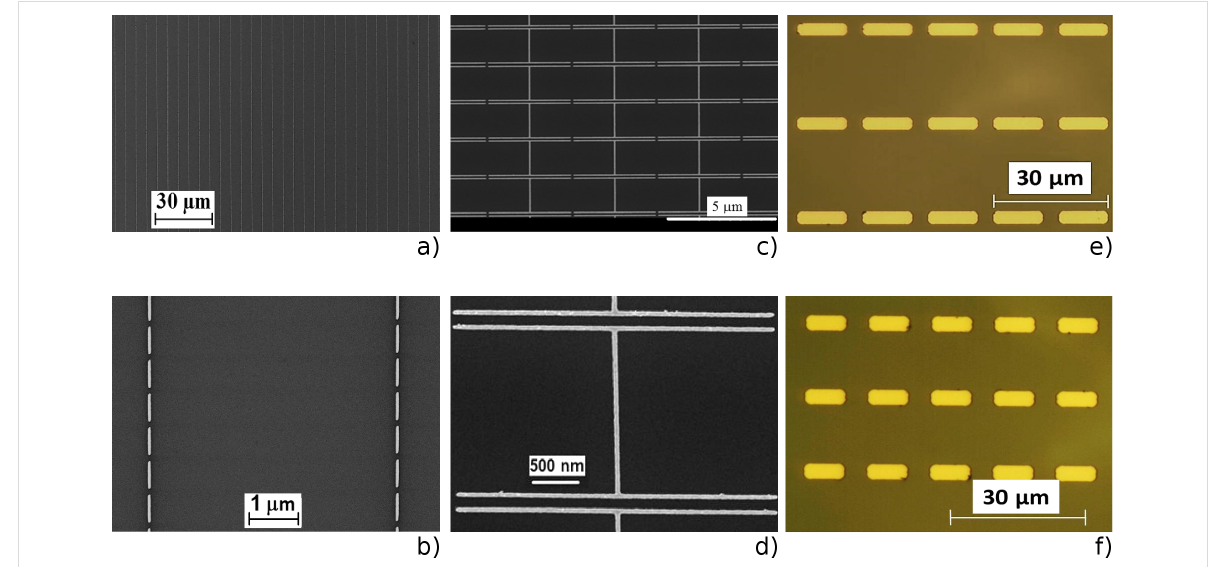
Figure 1: Representative SEM images of a) and b) linear and c) and d) H-shaped nanoantenna arrays with different resolution. e) and f) Optical images of the bare microantenna arrays of different